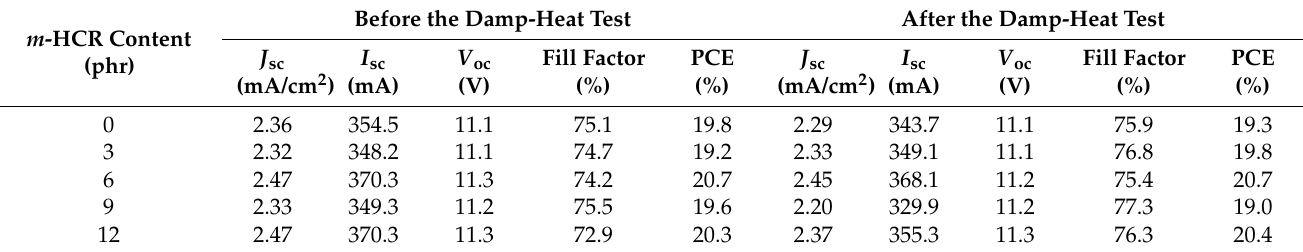
Figure 7. I – V curves of the test PV module before ( A ) and after ( B ) 1000 h of the damp-heat test. Table 2. I – V parameters of the test PV modules encapsulated with the crosslinked neat POE and POE blends with m -HCR.